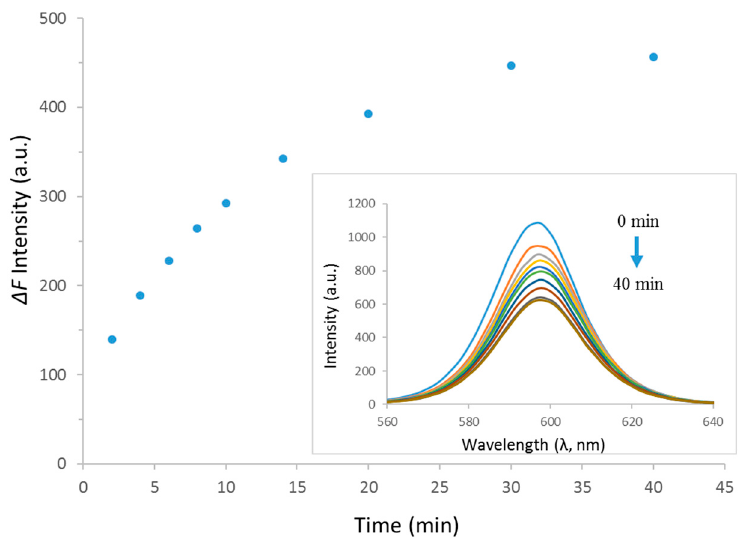
Figure 3. Typical time-dependent fluorescence changes of 2.5 nM quantum dots (QDs) in the presence of 637.5 U/L choline oxidase (ChOx), 40.8 U/L acetylcholinesterase (AChE) and 300 μ M acetylcholine chloride (ACh): 2, 4, 6, 8, 10, 14, 20, 30 and 40 min. The inset displays plots of emission spectra of QDs.